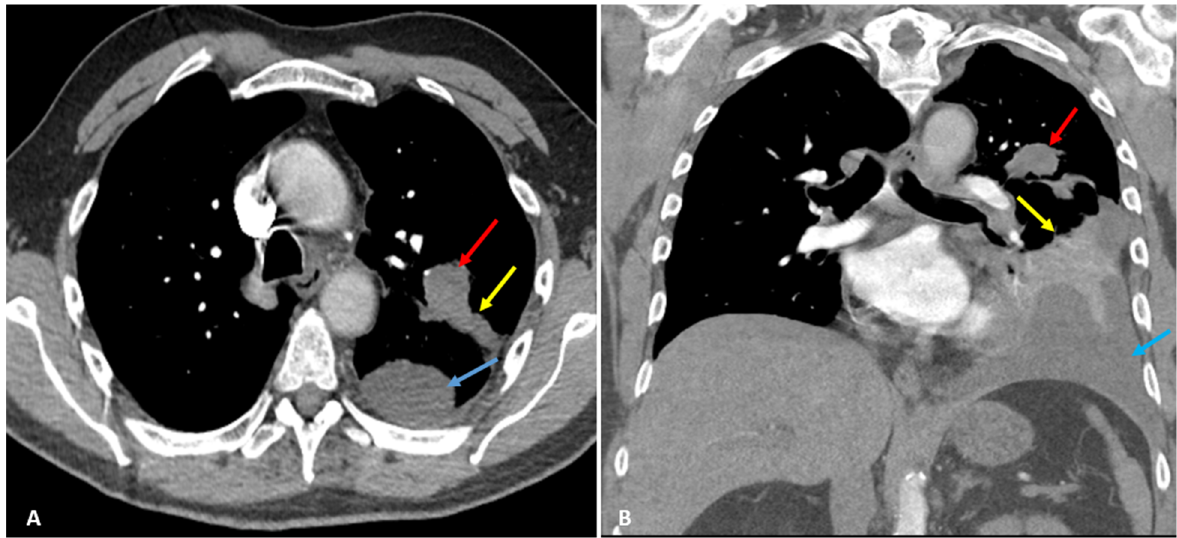
Figure 1. Axial ( A ) and coronal ( B ) CT scan with IV contrast shows left upper lobe peri-bronchial mass (red arrows) measuring approximately 3 × 2 cm in diameter. Distal obstructive atelectasis (yellow arrows) and left pleural effusion (blue arrows) are observed as well.